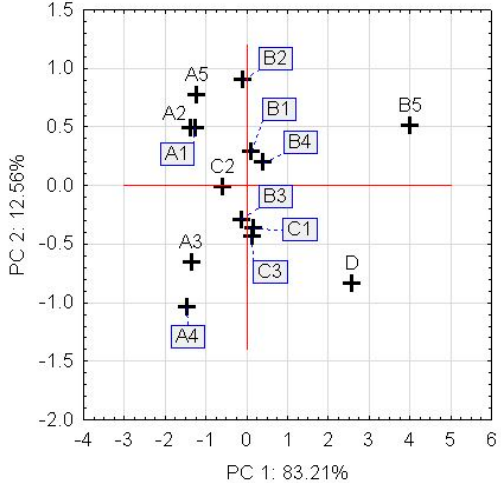
Figure 5. Principal components plot (PC1-PC2) of measurements in different room types. PC1 and PC2 refer to the first and second principal components obtained by principal component analysis of the standardized estimations from the portable gamma spectrometry of K, eU, and eTh. The first principle component (PC1) explains 83.21% of the variance of the dataset (standardized values of K, eU, and eTh measurements) while the second principle component (PC2) explains 12.56% of the variance of the studied dataset.